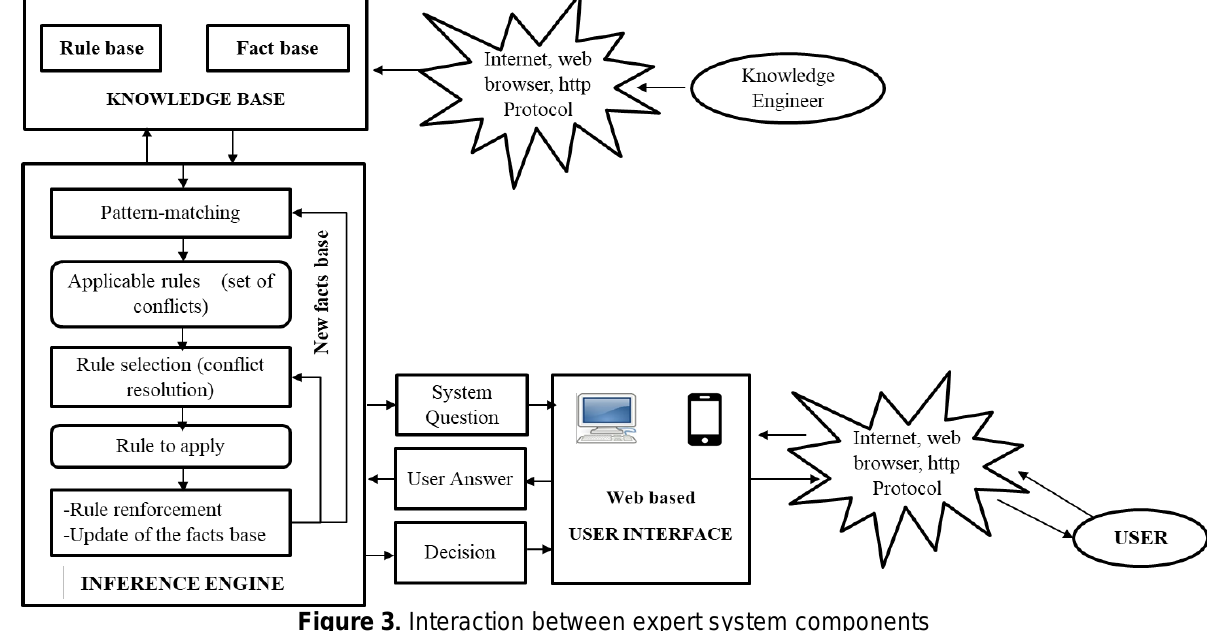
Figure 3 . Interaction between expert system